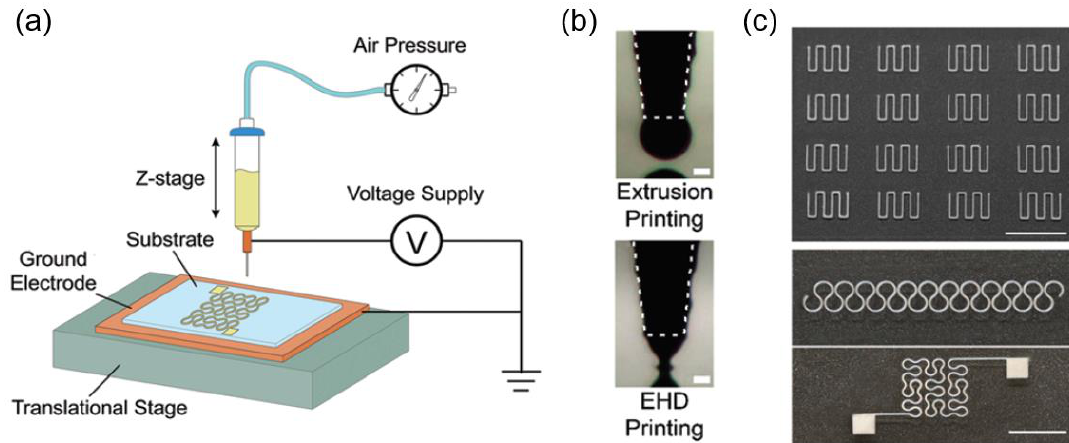
Figure 8. ( a ) Schematic of electrohydrodynamic (EHD) printing instrument. ( b ) Photographs of EHD nozzle with voltage on ( top ) and off ( bottom ) (scale bar: 100 μm). ( c ) Large-scale Ag NW pattern printed by EHD printing (scale bar: 1 cm). Reproduced with permission from [25]. Copyright 2018 Royal Society of Chemistry.